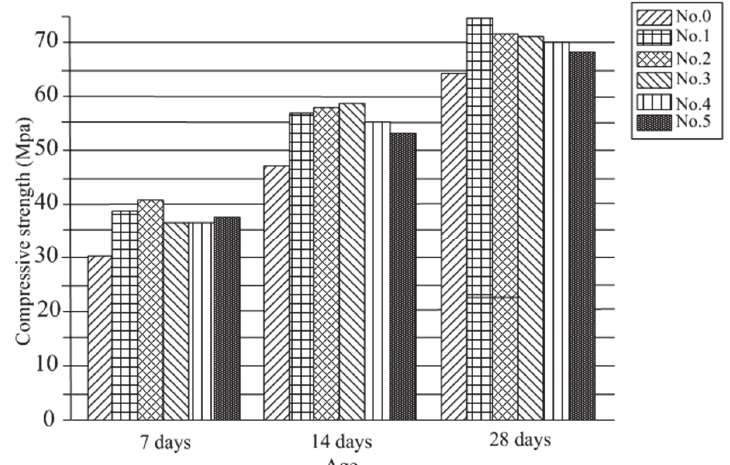
Figure 7: The variation of the compressive strength of carbon nano-tubes cement-based composite materials test specimens along with the change of